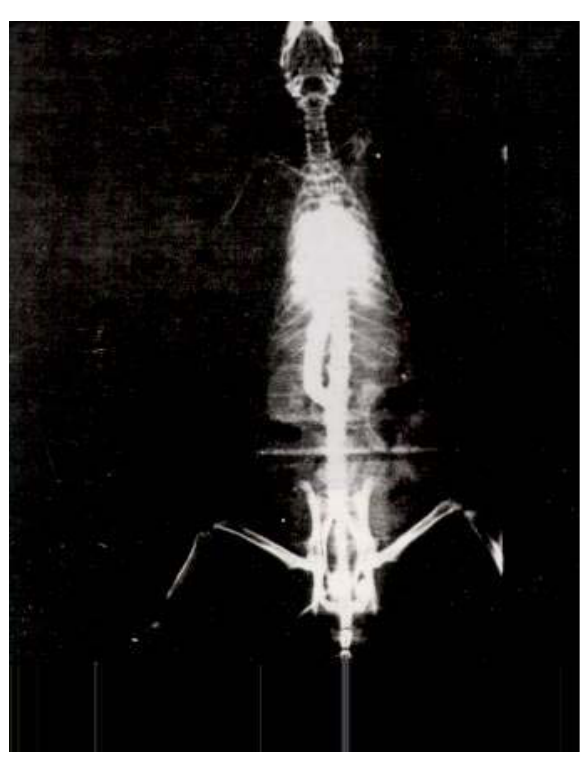
FIGURA 4 - Cavografia normal.